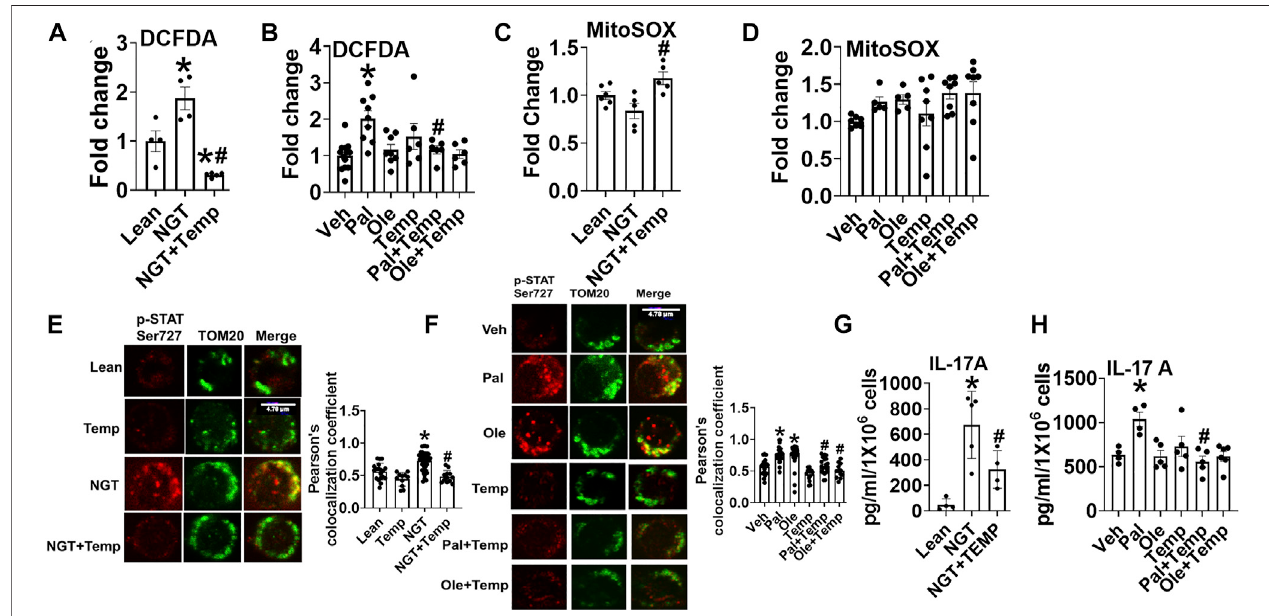
FIGURE 7 | Lowering cellular peroxide with tempol lowers NGT and pal-activated pSer727-STAT3-mitochondrial translocation and in fl ammation. (A) Peroxide production in cells from NGT subjects. (B) Peroxide production in cells treated as indicated. (C) Superoxide production in cells from NGT subjects. (D) Superoxide production in cells treated as indicated. (E) p-Ser727 STAT3 expression (F) , mitochondrial localization (left panel representative images, and right panel quanti fi cation) (G) cytokine production in cells from NGT subjects; (H) cytokine production by cells treated as indicated, as assessed via ELISA assay. N = 5 – 8, (A – D) ; N = 3 – 4, (E,F) ; N = 5, (G-H) . Each N represents cells obtained from one subject. * p < 0.05 vs. Lean or Veh, # p < 0.05 vs. NGT or Pal.